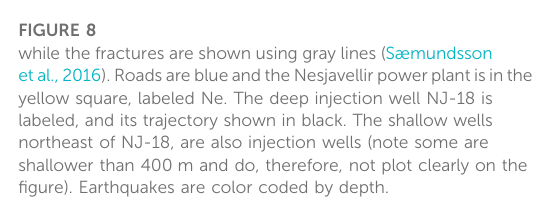
FIGURE 8 while the fractures are shown using gray lines (Sæmundsson etal.,2016).RoadsareblueandtheNesjavellirpowerplantisinthe yellow square, labeled Ne. The deep injection well NJ-18 is labeled, and its trajectory shown in black. The shallow wells northeast of NJ-18, are also injection wells (note some are shallower than 400 m and do, therefore, not plot clearly on the fi gure). Earthquakes are color coded by